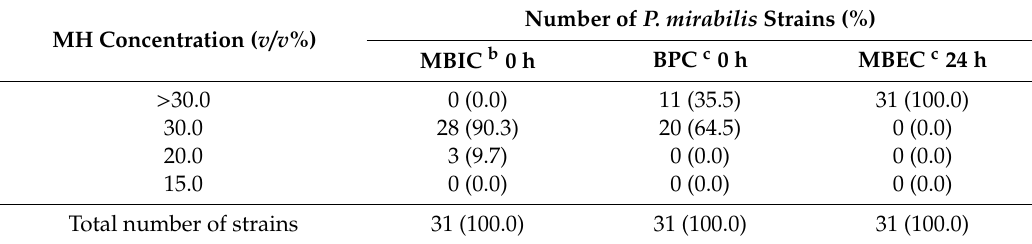
Table 3. Comparison of Proteus mirabilis a susceptibility to ethanol extract of propolis (EEP) and ethanol (EtOH). Number of P. mirabilis Strains C [ v / v %] MBIC b 0 h (%) BPC c 0 h (%) MBEC c 24 h (%) EEP EtOH EEP EtOH EEP EtOH > 40.0% - - - - - 3 (9.67) 40.0 - - - - - 6 (19.3) 20.0 - 5 (16.1) 10.0 5.0 4 (12.9) 22 (71.0) 12 (38.7) 17 (54.8)